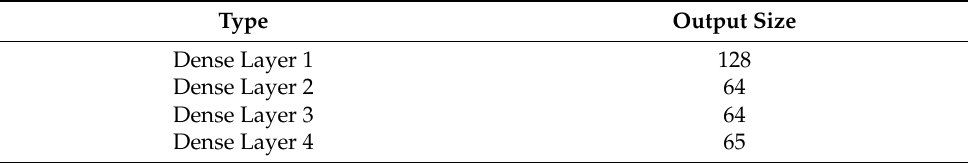
Table 2. Detail for each layer of the